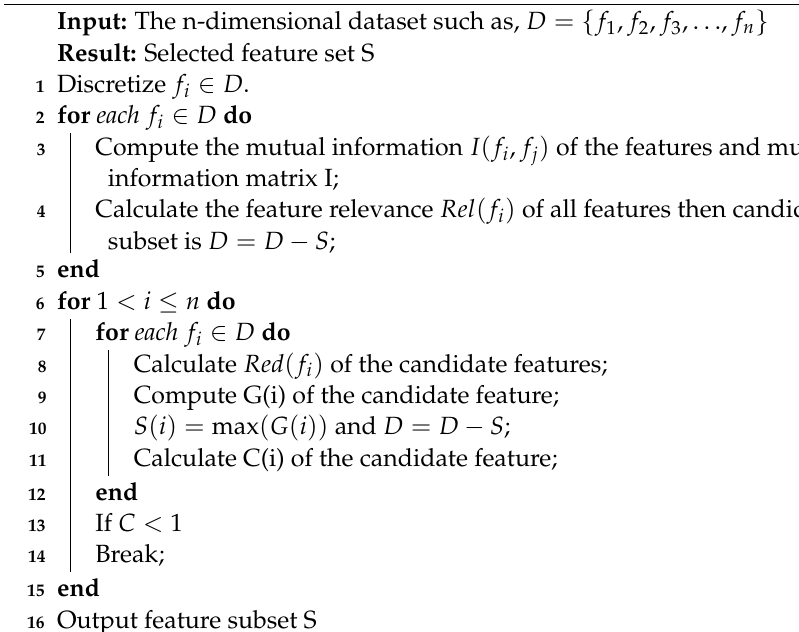
Algorithm 3: The procedure for applying the IG-based FS method